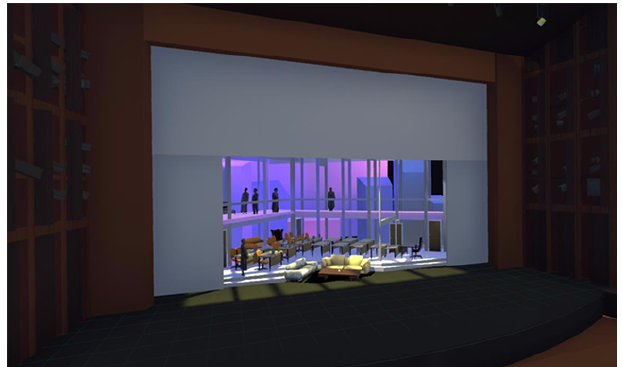
Figure 15. Possible previs outcome: 3D representation of a theater stage with different lights, props and virtual